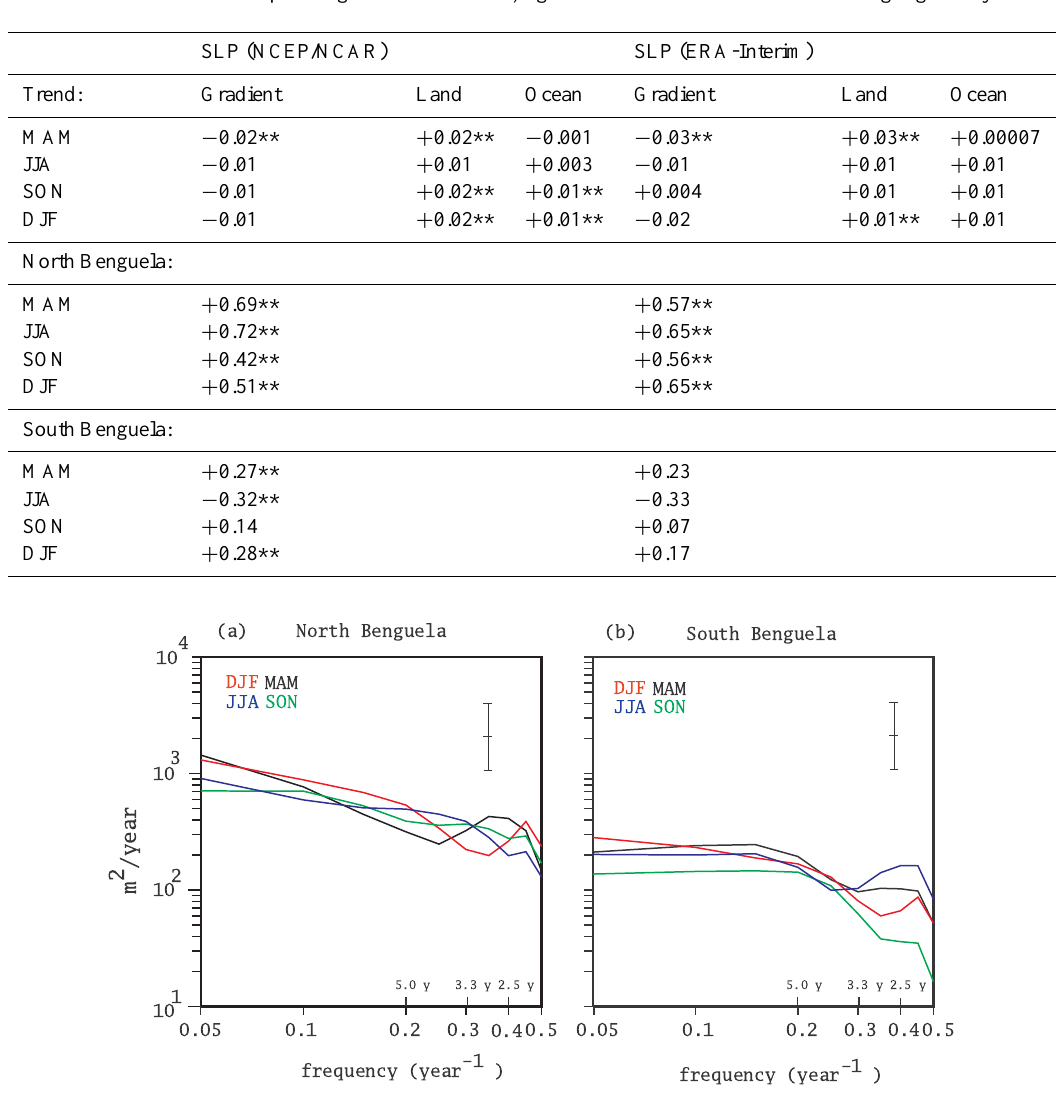
Figure 12. Spectral density of the upwelling indices derived from the vertical velocity in the STORM simulation in North Benguela (a) and South Benguela (b) in the period 1950–2010. The vertical black lines indicate the 90% confidence